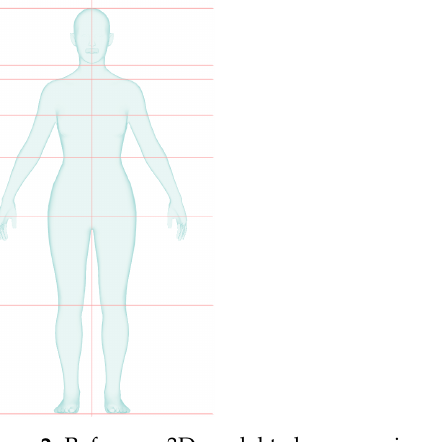
Figure 2. Reference 3D model to be approximated by convex volumes. Planar data (red lines). Table 2. Characteristics of the input data of the reference 3D model.